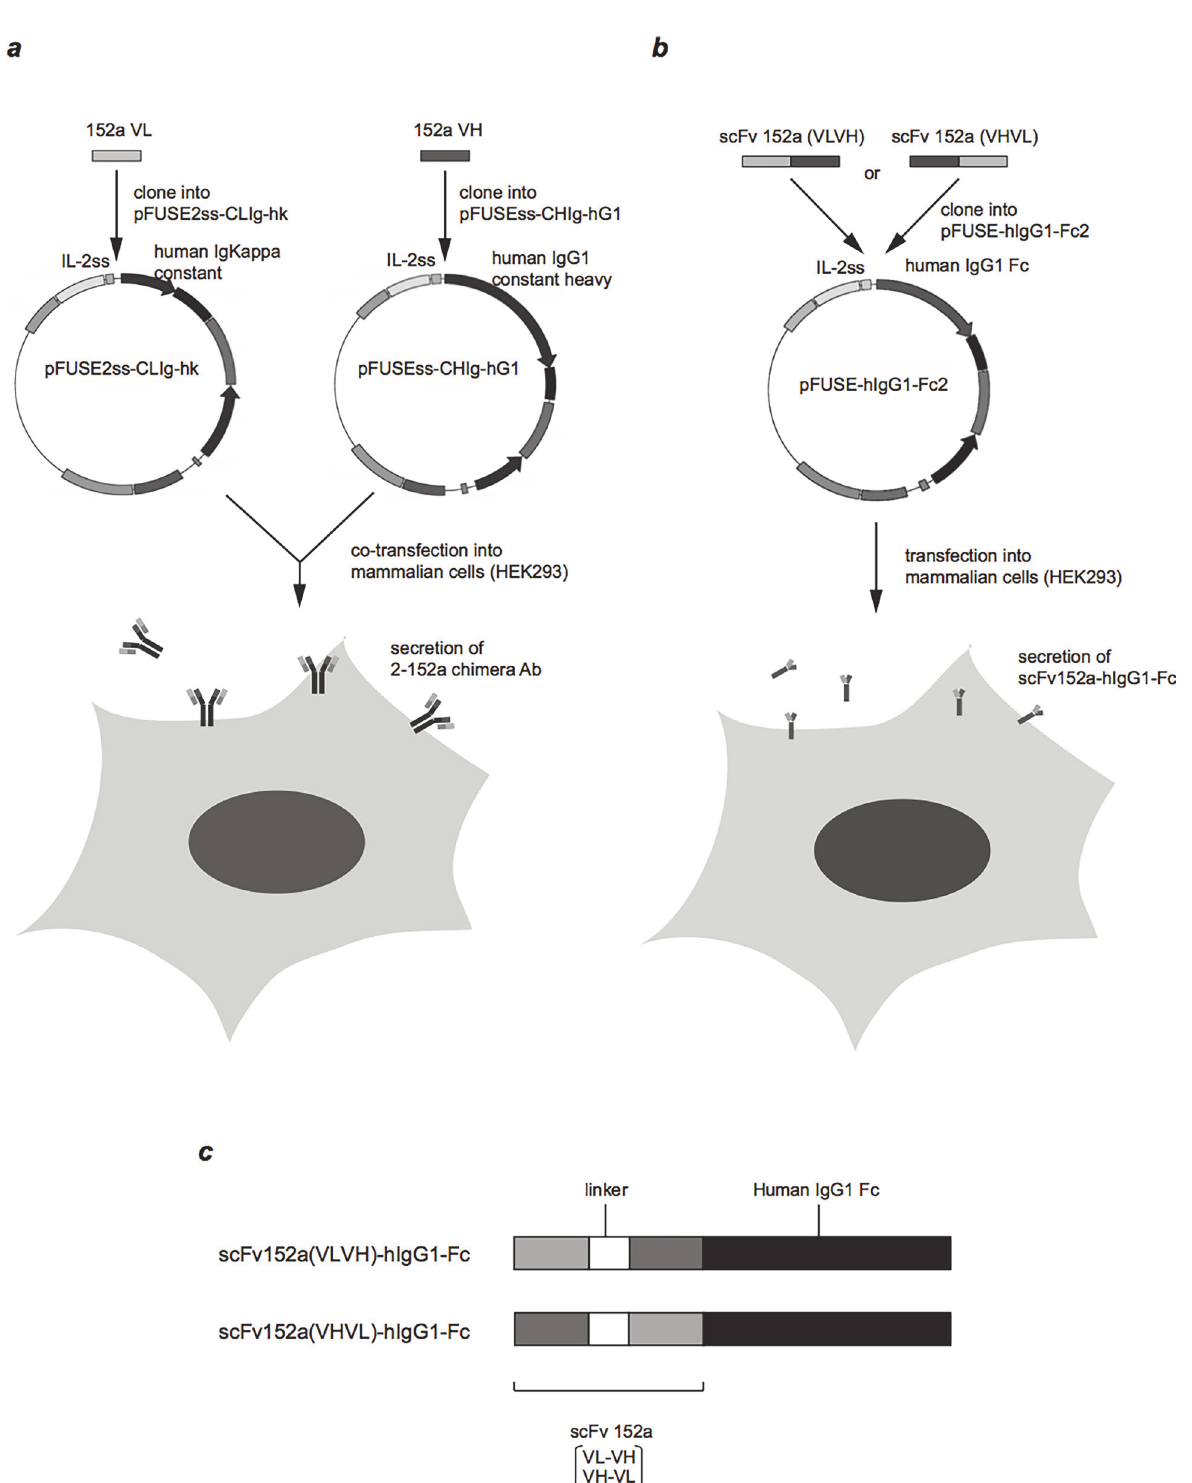
Fig 3. Construction of a chimeric antibody and scFv consisting of the 2-152a MAb antigen-binding domain and the human IgG constant domain. ( a ) The 2-152a VL and VH cDNAs were isolated from hybridoma #2-152a and cloned into pFUSE2ss-CLIg-hk and pFUSEss-CHIg-hG1, respectively. HEK293 cells were co-transfected with the expression vector harboring the chimeric Ig (152a Ch-L; pFUSE2ss-152aVL-CLIg-hk, 152a Ch-H; pFUSEss- 152aVH-CHIg-hG1). The 152a Chimera Ab or chimeric Ig (152a Ch-L, 152a Ch-H) was secreted into the culture medium and then purified from the culture